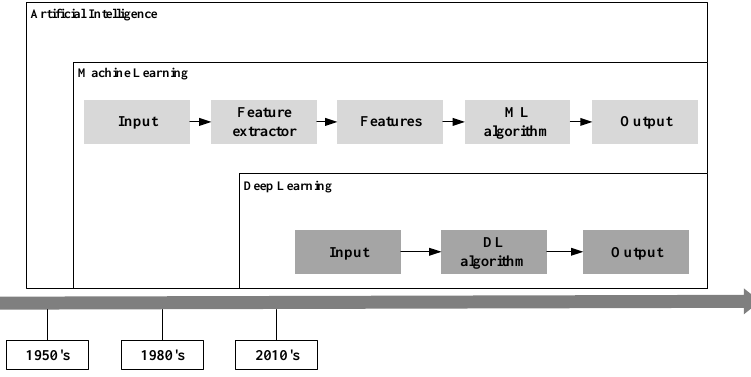
Figure 1. The trend of machine learning.